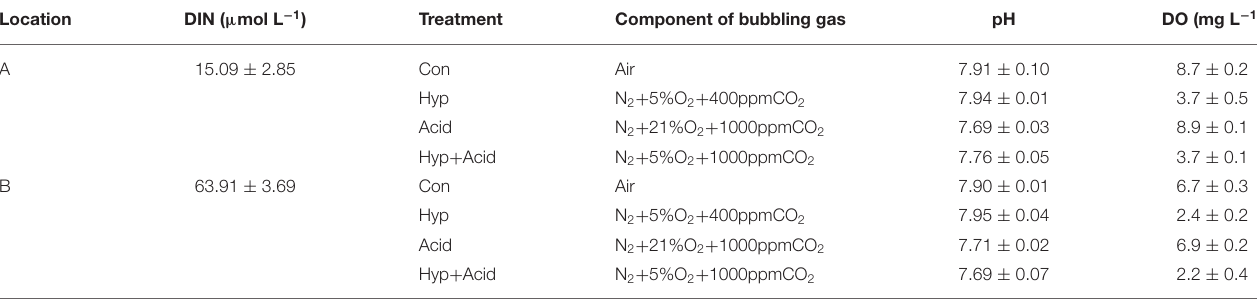
TABLE 1 | Overview of experiments, including sampling locations, treatments (Con, control; Hyp, hypoxia; Acid, acidification; Hyp + Acid, combination of hypoxia and acidification), and components of bubbling gas, pH, and dissolved oxygen (DO). Location DIN ( µ mol L − 1 ) Treatment Component of bubbling